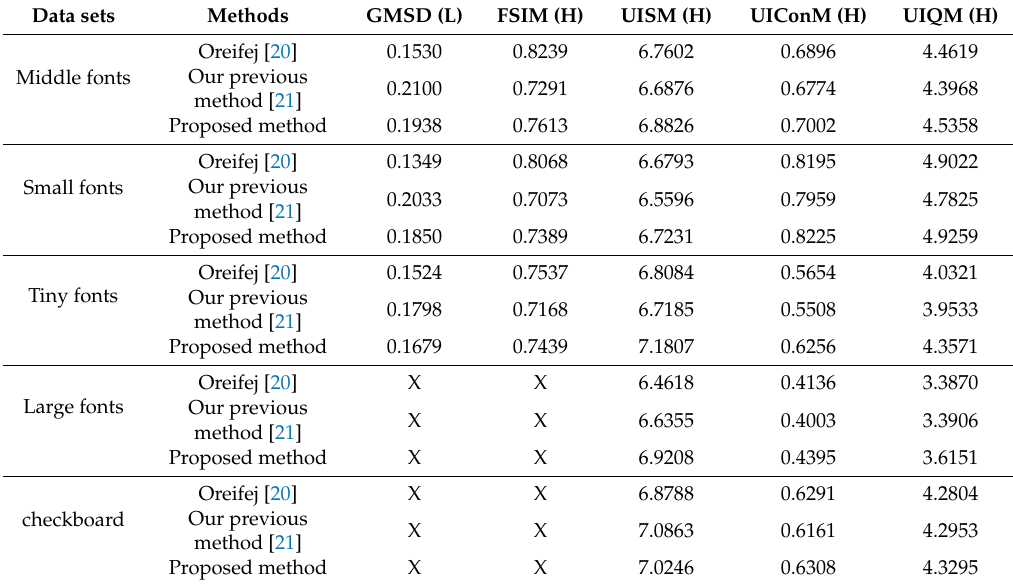
Table 2. Comparison of image quality metrics among the Oreifej method [20], the proposed method, and the previous method [21] 1.